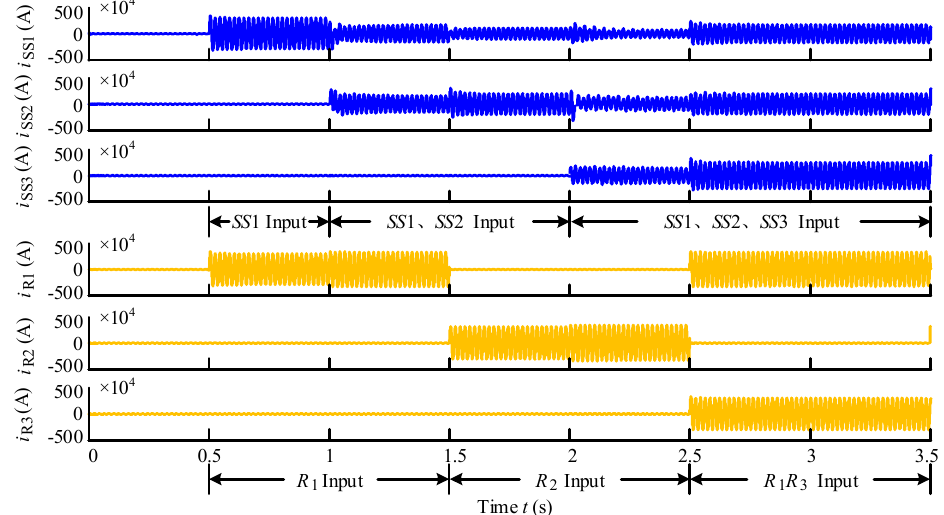
Figure 14. The current waves of the traction substations and locomotives in 0 ‒ 3.5 s.